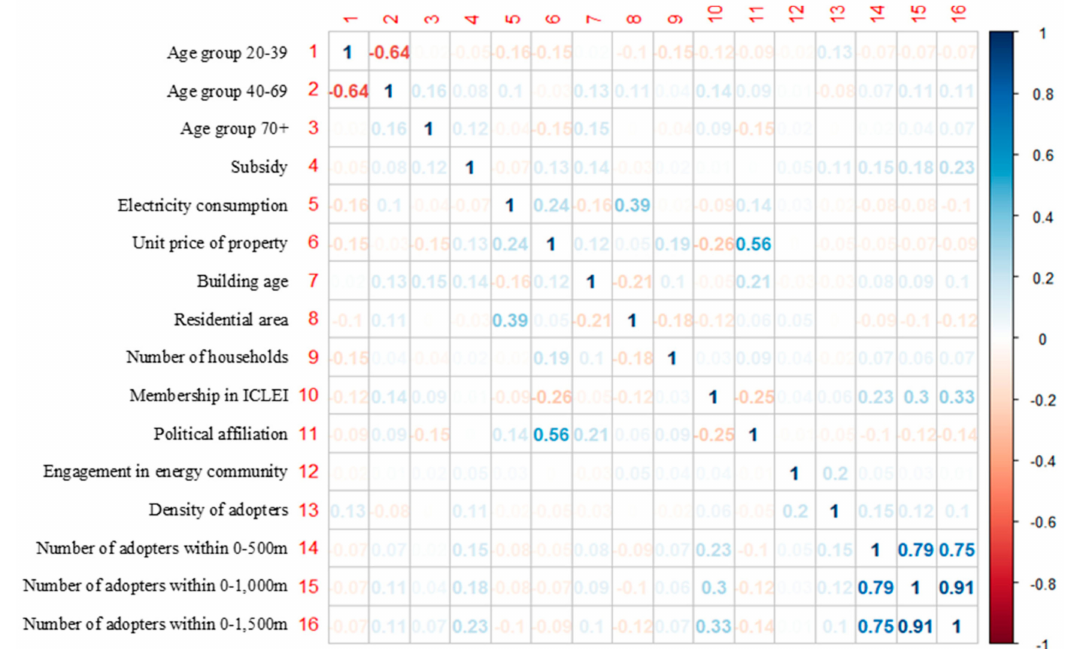
Figure 6. Correlation matrix for independent